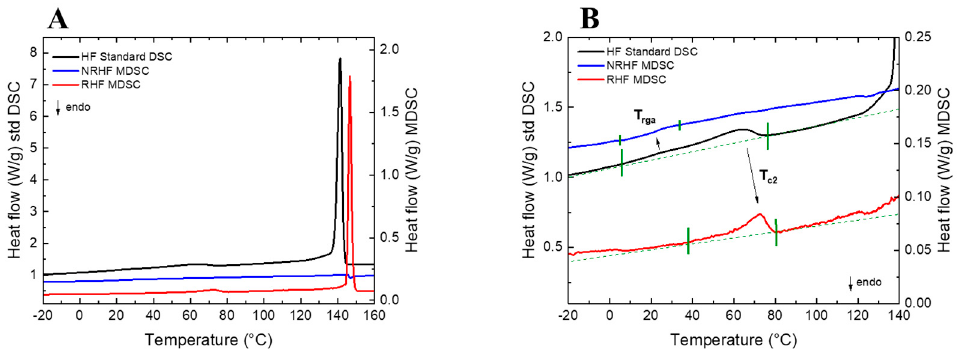
Figure 4. Thermal transitions obtained by standard DSC and MDSC upon cooling from the Melt ( A ), and zoom in of DSC/MDSC thermogram corresponding to the controversial weak thermal transitions of the rigid amorphous phase densification (T rga ) and of a secondary crystallization (T c2 ) ( B